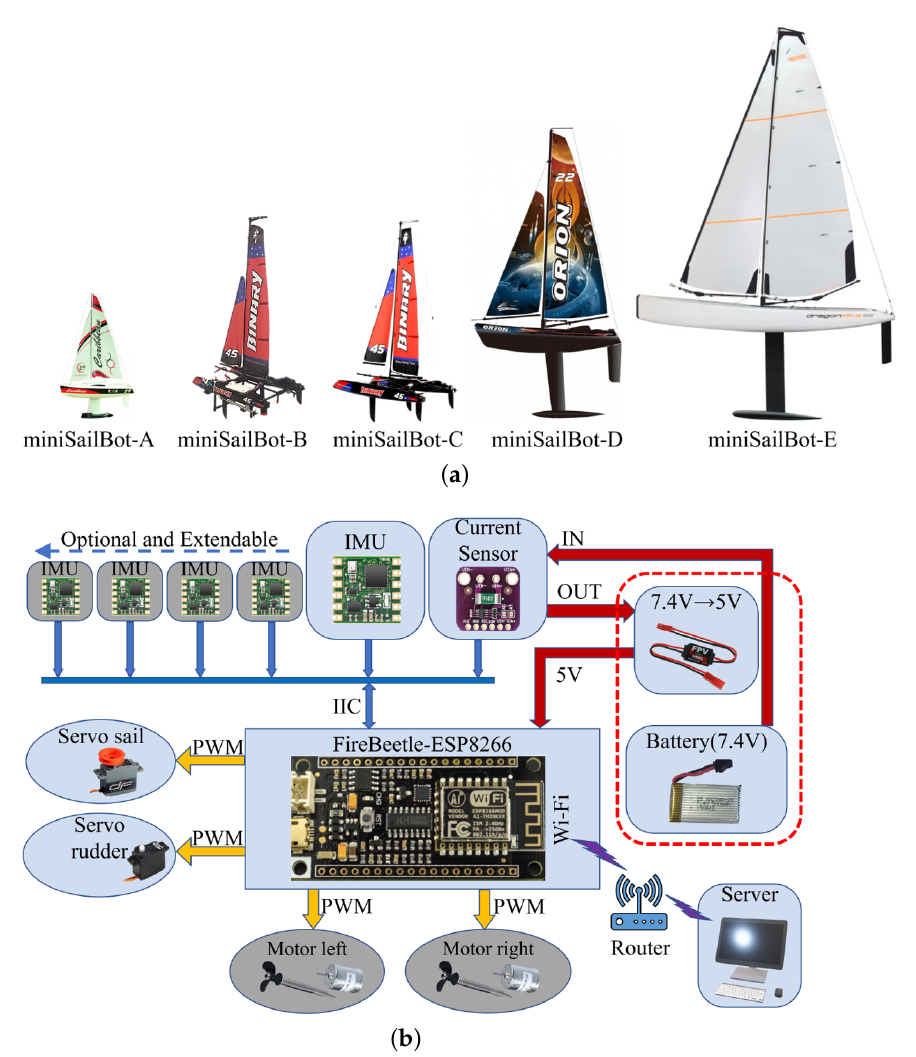
Figure 2. The miniSailBots and electronic hardware. ( a ) miniSailBots of different sizes. ( b ) Diagram of electronic hardware modification